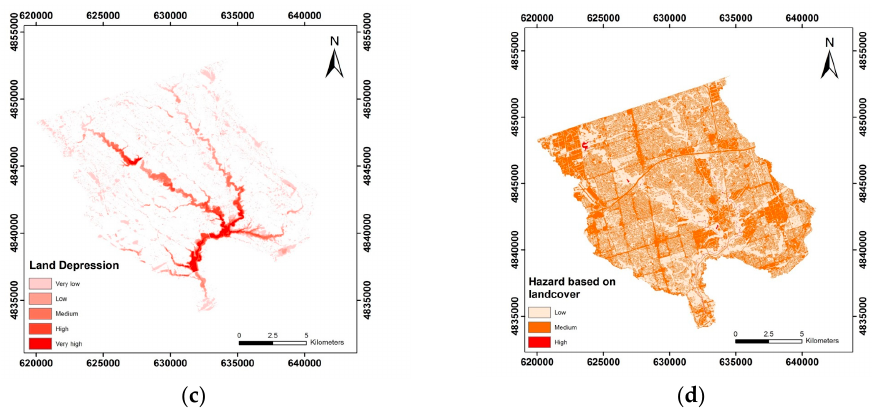
Figure 5. Flood hazard areas maps. ( a ) Based on Don River flood lines; ( b ) based on terrain slope; ( c ) based on land depressions; ( d ) based on land cover areas of vegetation, water, impervious surfaces, bare soil, and grasslands. The total flood hazard map derived by Equation (4) is shown in Figure 6.